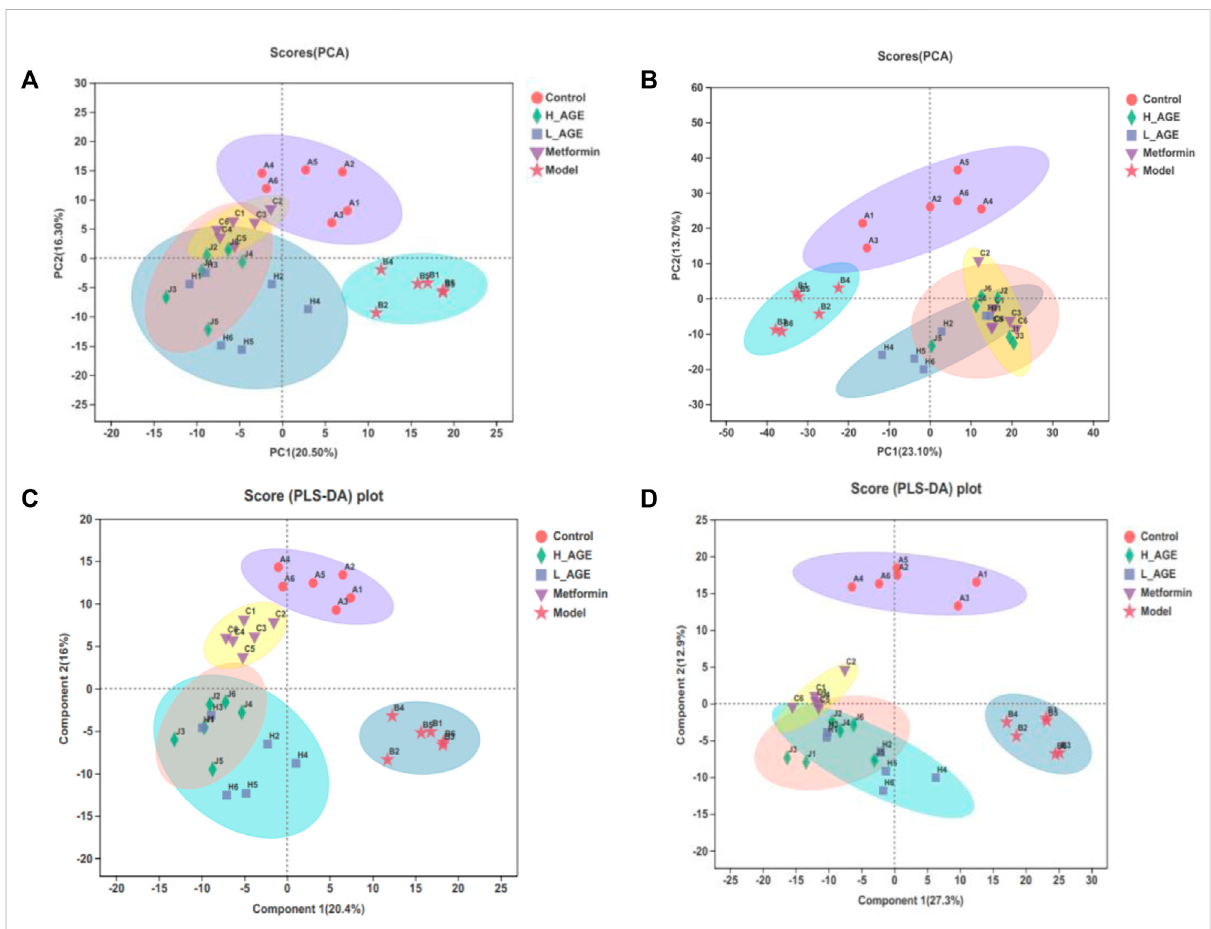
FIGURE 4 PCA score diagrams of the samples from control, model, and treatment rats in ESI + mode (A) or ESI- mode (B) . PLS-DA score diagrams of the samples from control, model, and treatment rats in ESI+ (C) or ESI- (D) modes. The ellipse expresses that the con fi dence interval is